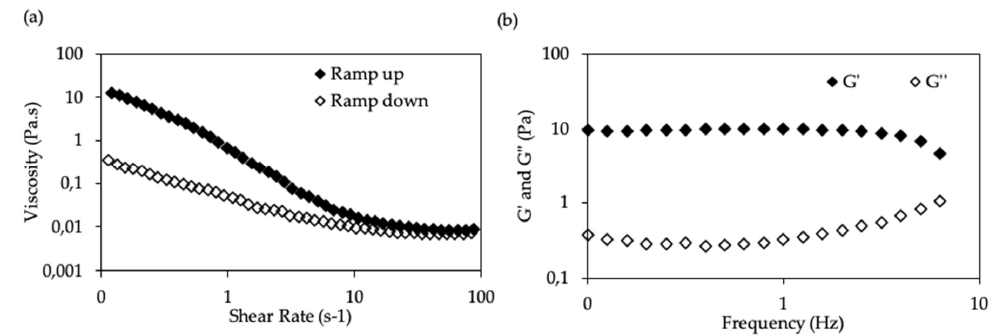
Figure 6. Flow curve ( a ) and oscillatory results obtained from a frequency sweep test ( b ) of the CC-stabilized emulsion.